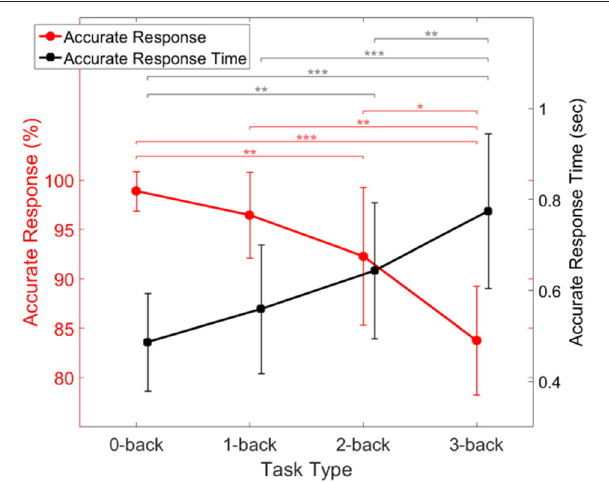
FIGURE 7 | Behavioral performance of the subjects during task conditions of increasing difficulty, showing response accuracy (red) and response time (black). Error bars indicate the standard deviation of inter-subject variability. Asterisks indicate statistical significance derived from a two-way ANOVA comparison of each two response accuracy (red) or response time (black) (* p < 0.05, ** p < 0.001, *** p <